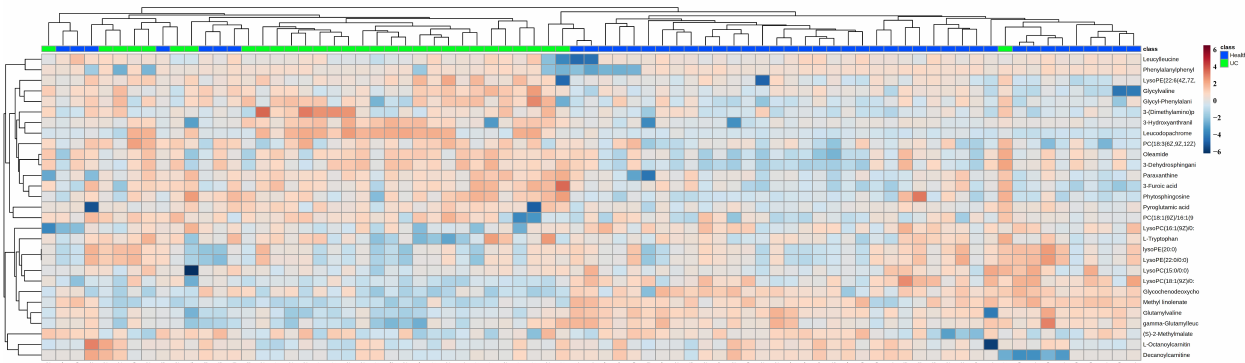
Figure 2. Heatmap of the 31 differential endogenous serum metabolites in the healthy and UC groups. Red represents the metabolites in high abundance and blue represents the metabolites in low